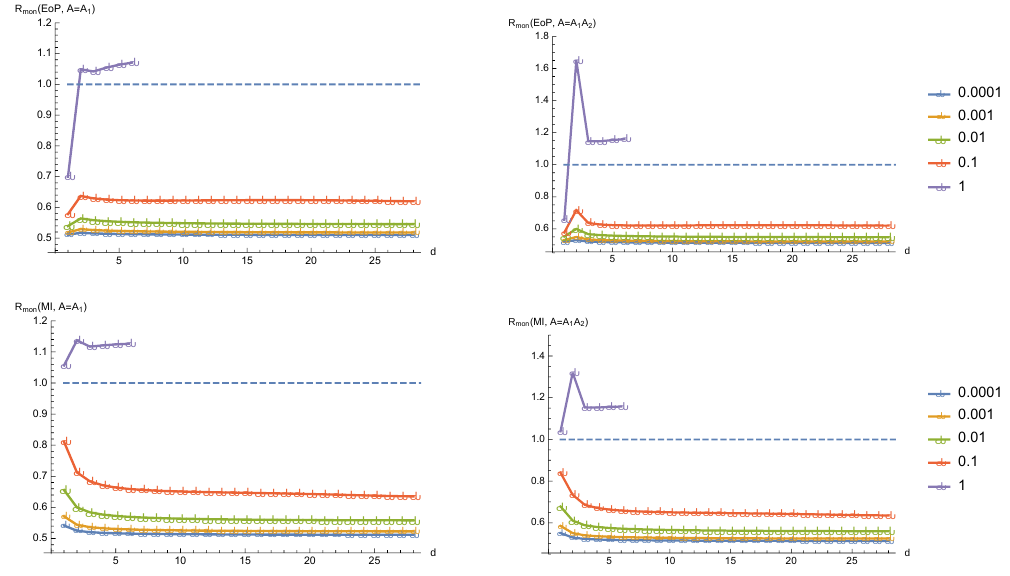
Figure 16 . The ratio R mon of the monogamy inequality of EoP (upper graphs) or mutual infor- mation (lower graphs). R mon < 1 means the violation of the monogamy. For all massless